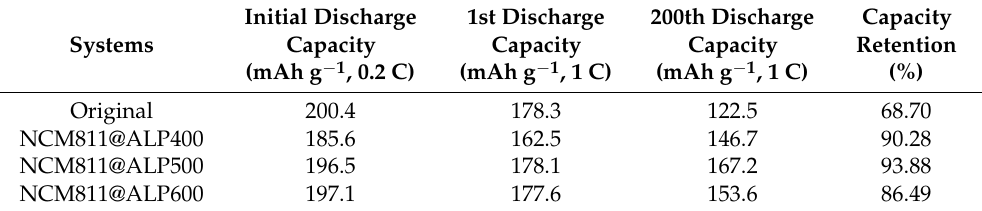
Figure 5. ( a ) Initial discharge curves at 0.2 C in the range of 2.7–4.3 V at 30 ◦ C for bare NCM811 and NCM811@ALP samples. ( b ) Cycle performances for bare NCM811 and NCM811@ALP samples at 1 C in the range of 2.7–4.3 V at 30 ◦ C. ( c ) Cycle performances for bare NCM811 and NCM811@ALP samples at 1 C in the range of 2.7–4.3 V at 60 ◦ C. ( d ) Rate capacities from 0.2 C to 5 C for bare NCM811 and NCM811@ALP samples in the range of 2.7–4.3 V at 30 ◦ C. Table 2. Electrochemical performance of the pristine and Al(PO 3 ) 3 -coated LiNi 0.8 Co 0.1 Mn 0.1 O 2